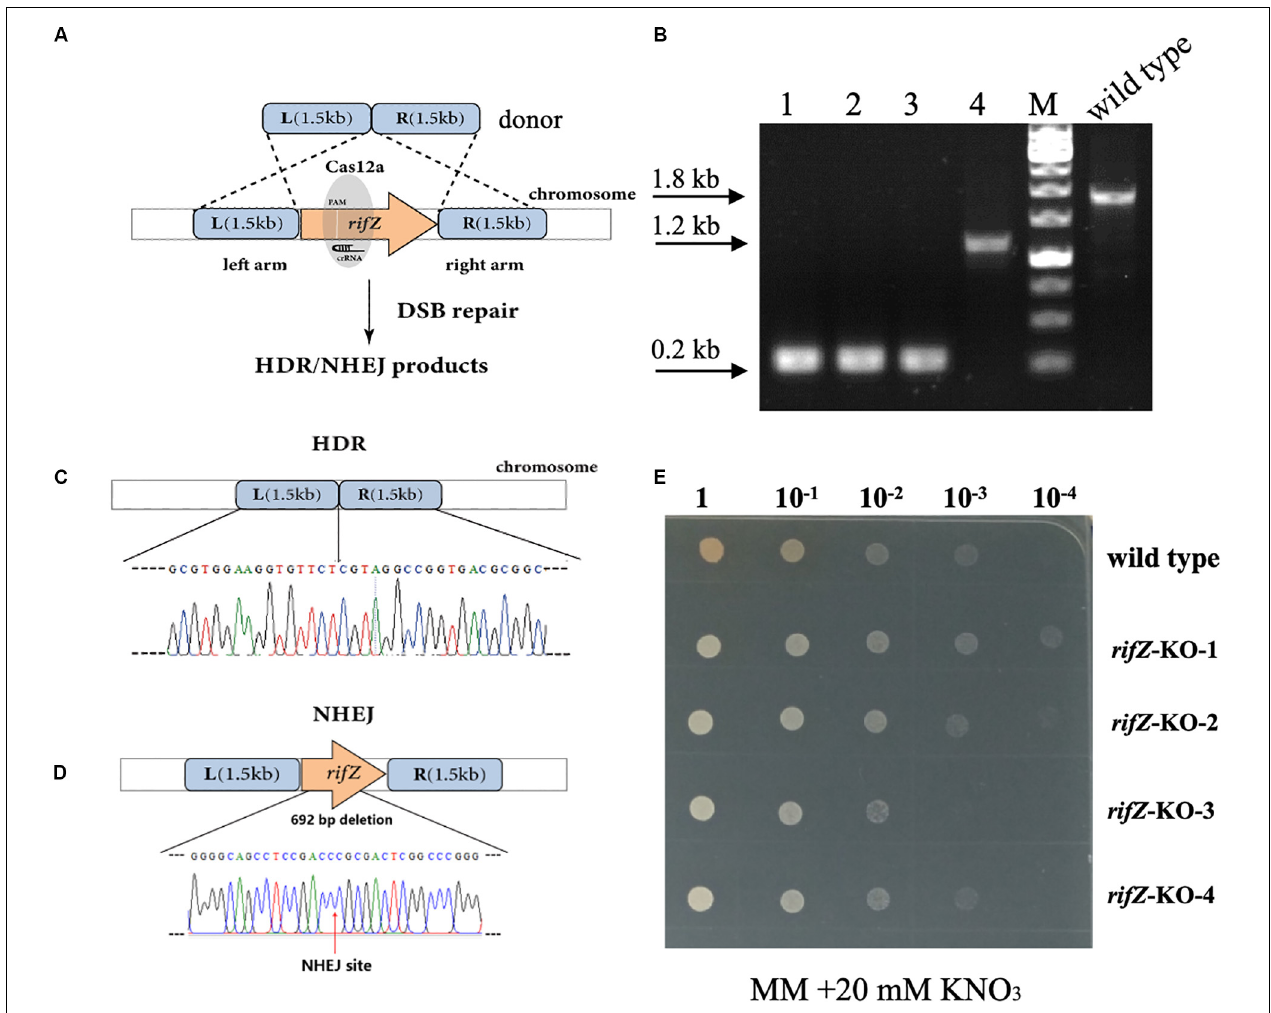
FIGURE 4 | Markerless deletion of rifZ gene with the Cas12a and HDR systems in U32. (A) Schematic of markerless deletion of rifZ gene. Cas12a-generated DSBs in rifZ could be repaired by HDR. (B) Verification of rifZ deletion mutants by colony PCR with paired primers of rifZ+P-F and rifZ+P-R. M, GeneRuler 1 kb DNA Ladder (Thermo Scientific). Lanes 1–4 represented rifZ -KO-1 to rifZ -KO-4, respectively. (C) Sanger sequencing results from the amplicon of rifZ -KO-1 in Figure 4B . (D) Schematic of the rifZ -KO-4 mutant in Figure 4B . The mutant was obtained via NHEJ-mediated repair of the Cas12a-generated DSBs in rifZ gene. Confirmed by Sanger sequencing, 692-bp sequences were found to be deleted at the Cas12a cleavage site. (E) The growth phenotype of rifZ mutants on minimal medium. Serially diluted liquid culture was spotted on plates and cultured at 30 ◦ C for 5 days, and only the wild type produced pigmented rifamycin